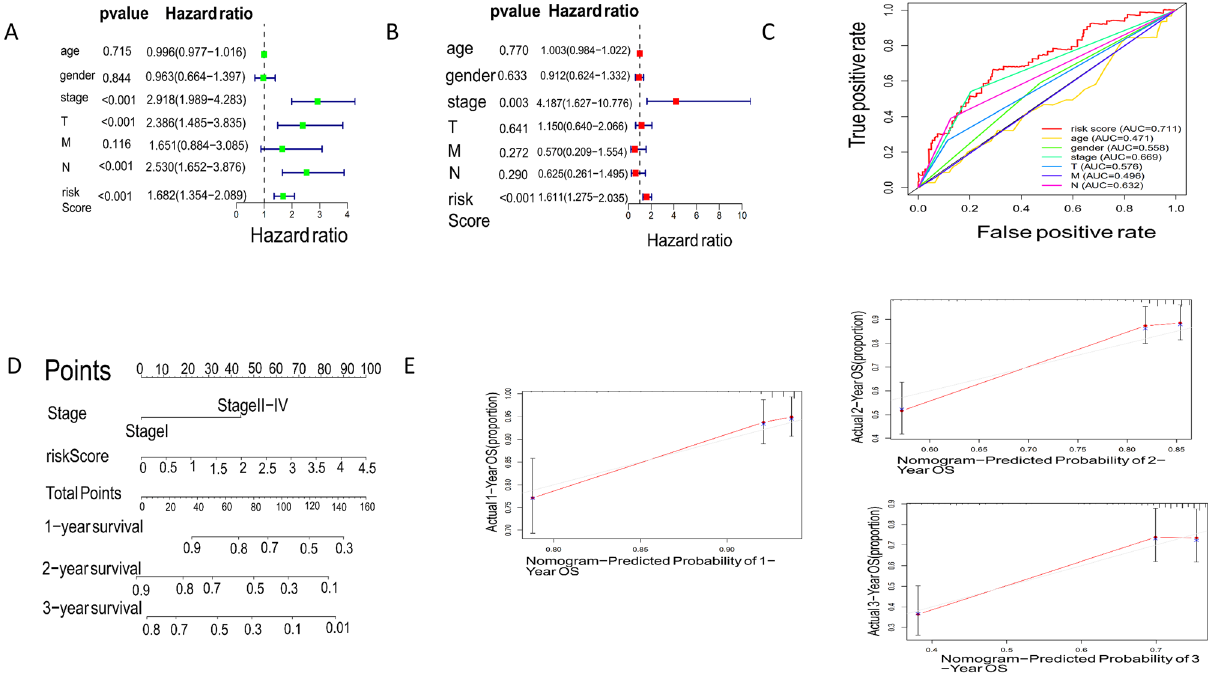
Figure 6. Establishment and evaluation of predictive nomogram in early diagnosis and prognosis model. ( A , B ), Forest map showed that independent clinical prognostic factors were obtained by univariate ( A ) and multivariate ( B ) Cox analysis. ( C ) The ROC curve exhibited the predictive performance of each independent predictive factor. ( D ) A nomogram for predicting OS in significantly independent prognostic factors. ( E ) Calibration plot of the nomogram for the probability of OS at 1, 2 and 3